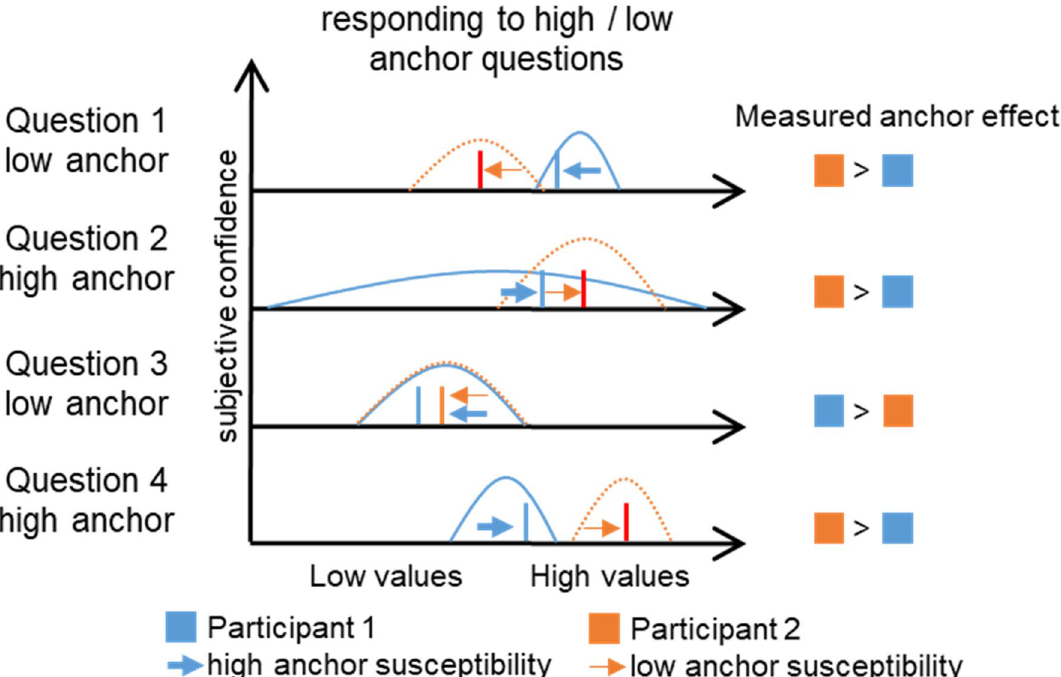
Figure 1. Schematic illustration of problems to quantify anchor effects on the individual level. Hypothetical underlying uncertainties for two persons (blue and orange) show different possible ranges of estimates for a given question. Bars illustrate their given estimates, which are shifted by anchors within their range of possible answers due to uncertainty. The blue participant is actually much more susceptible to anchors than the orange participants, but a stronger anchor effect (lower estimate for low anchor) is only observed for question 3, when they hypothetically have identical knowledge and thus exhibit the same range of plausible values (Question